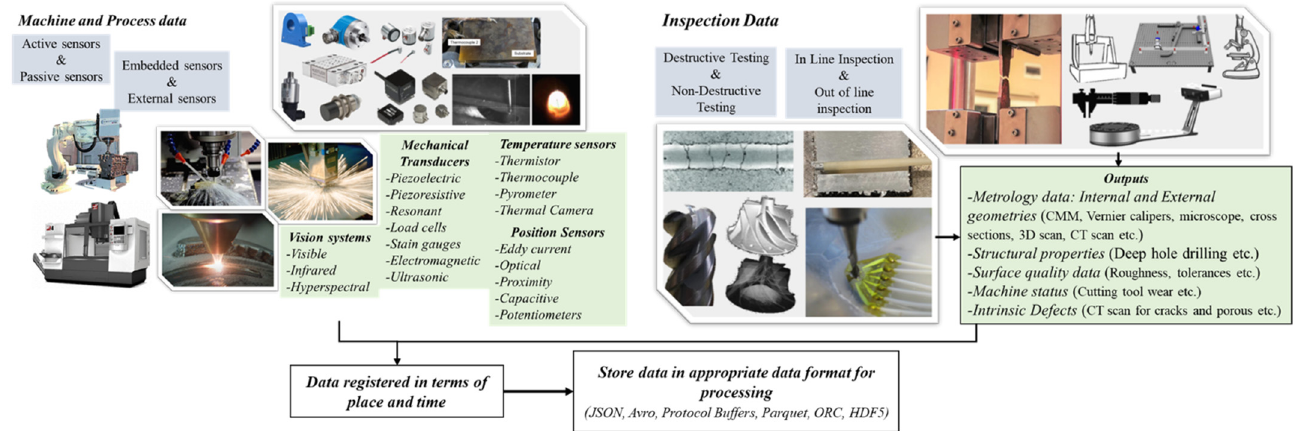
Figure 5. Sensors and monitoring devices to represent the physical process